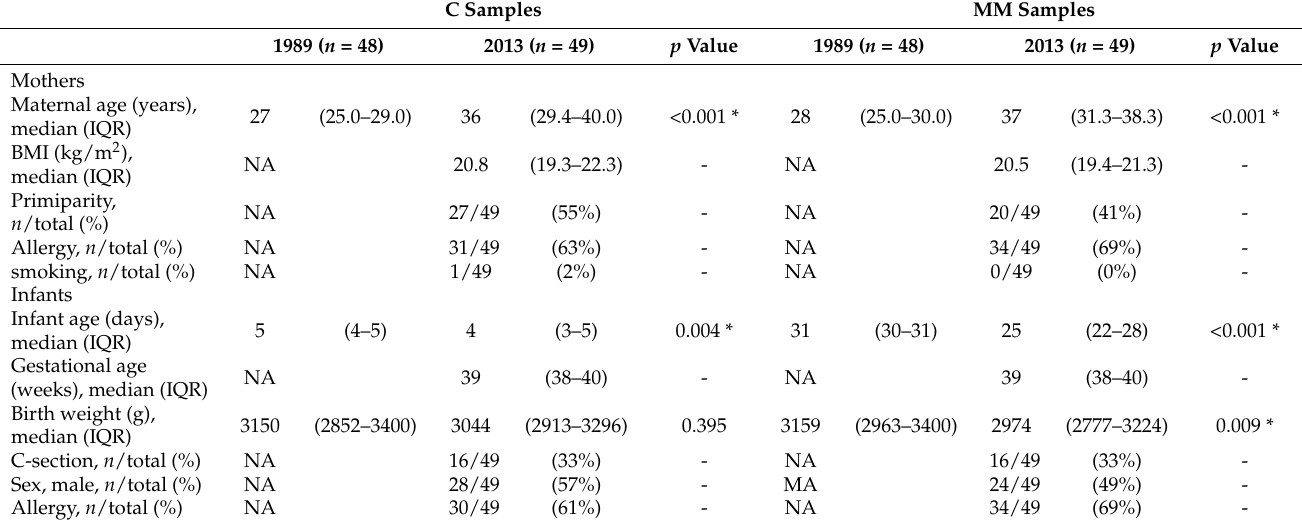
Table 1. Background characteristics of mothers and infants in this study. C